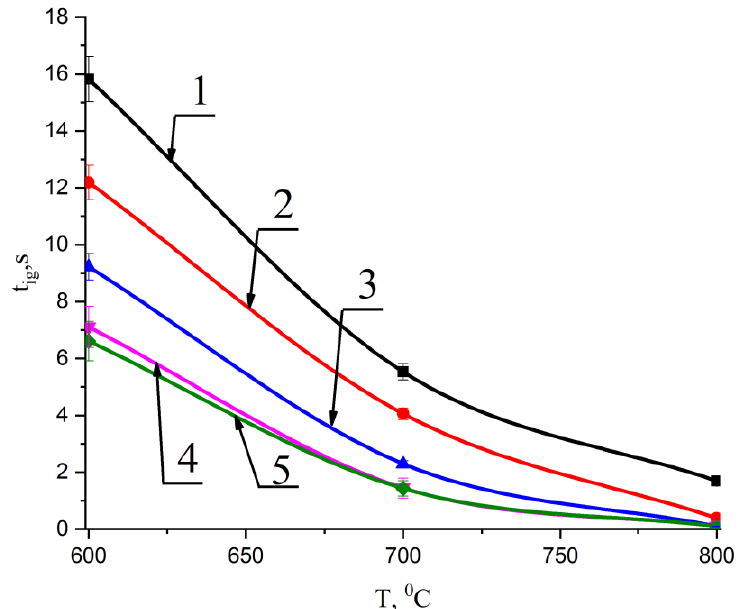
Figure 5. Change in ignition delay times for pellets made of T grade coal, cedar husks, and mixtures based on them with temperature at different concentrations of the second component: 1—100% coal; 2—90% coal, 10% cedar husk; 3—75% coal, 25% cedar husk; 4—50% coal, 50% cedar husk; and 5—100% cedar husk.